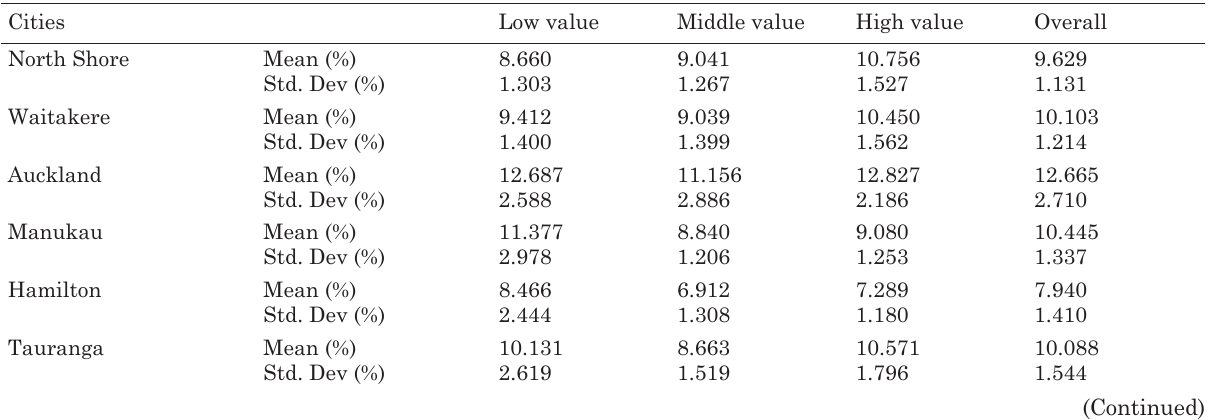
Table 4. Summarised monthly coefficient of dispersion (COD) of assessment ratios,